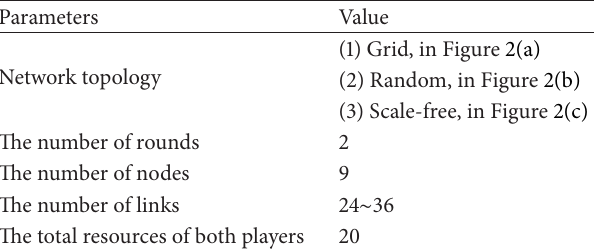
Table 8: Experiment parameters